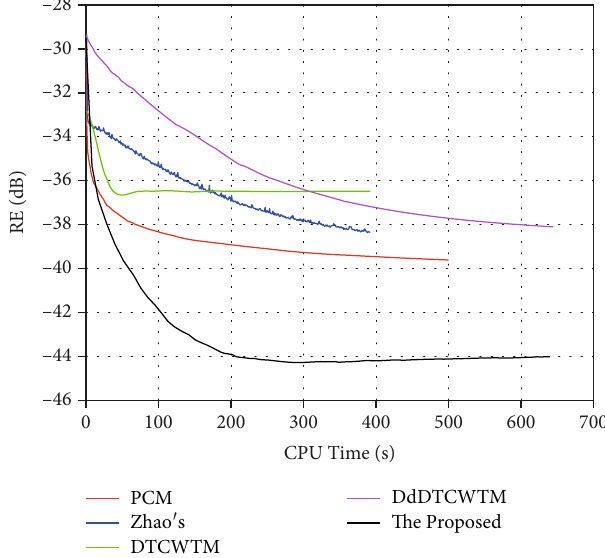
Figure 5: The RE curves for the fi rst